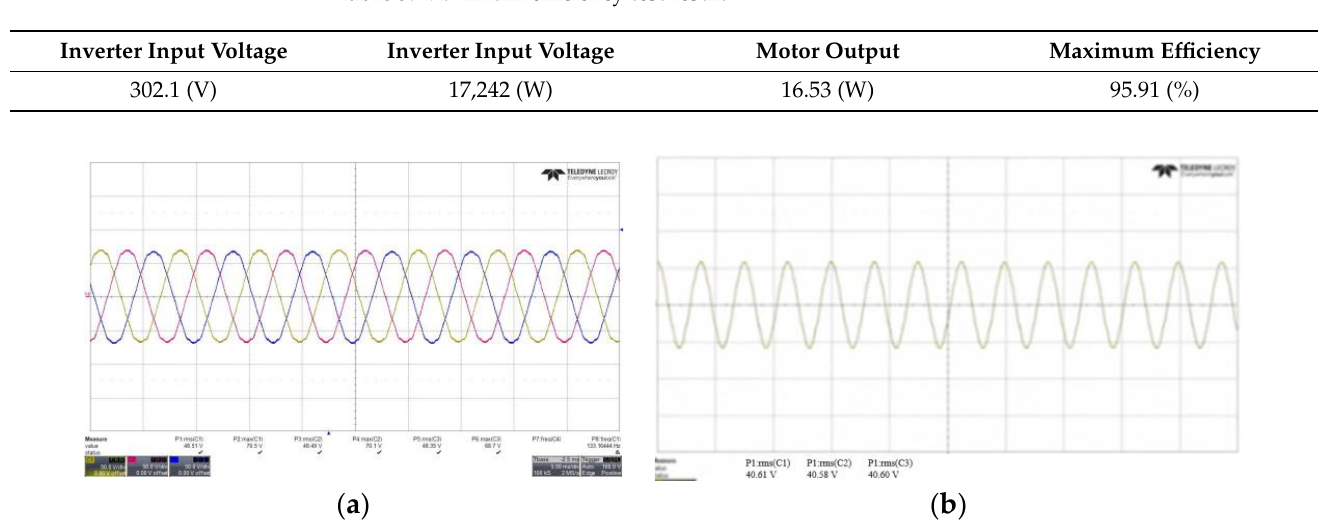
Table 5. Maximum efficiency test result.